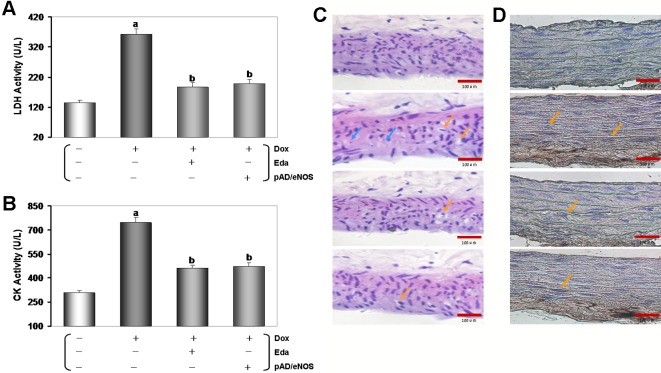
Changes of tissues injury, histopathological, and apoptosis in Dox-treated. (A and B) Activities of mice’s serum lactate dehydrogenase (LDH) and creatine kinase (CK). Data are presented as the mean ± S.E.M. for fifteen individual experiments. a: P < 0.01, vs. the control group; b: P < 0.01, vs. the Dox group. (C) hematoxylin-eosin (H&E) staining was performed for morphological analysis in the thoracic aortas tissue. Blue arrow: spotty necrosis; Orange arrow: hypertrophy of interstitial cells. (D) TUNEL staining was performed for morphological analysis in the thoracic aortas tissue. Orange arrow: TUNEL-positive cells.